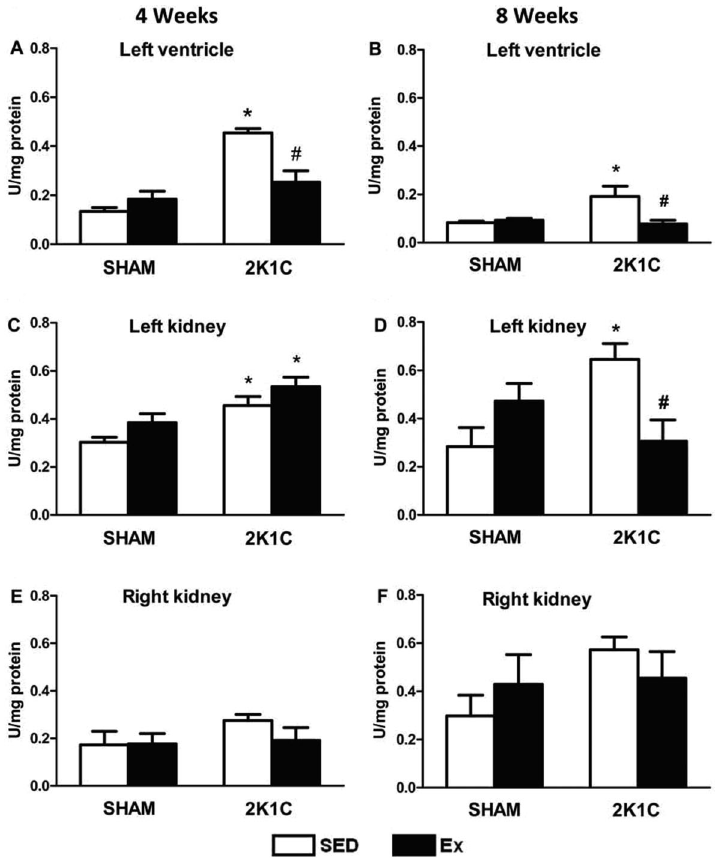
Figure 8. Relative level of TBARS, reported as malondialdehyde equivalents (U/mg protein), in the left ventricle ( A and B ), left kidney ( C and D ), and right kidney ( E and F ) of normotensive (SHAM, n=10) and hypertensive (2K1C, n=10) rats, either sedentary (SED) or subjected to 4 or 8 weeks of physical exercise training (Ex). *P o 0.05 compared to SHAM SED. # P o 0.05 compared to 2K1C SED (ANOVA followed by Bonferroni